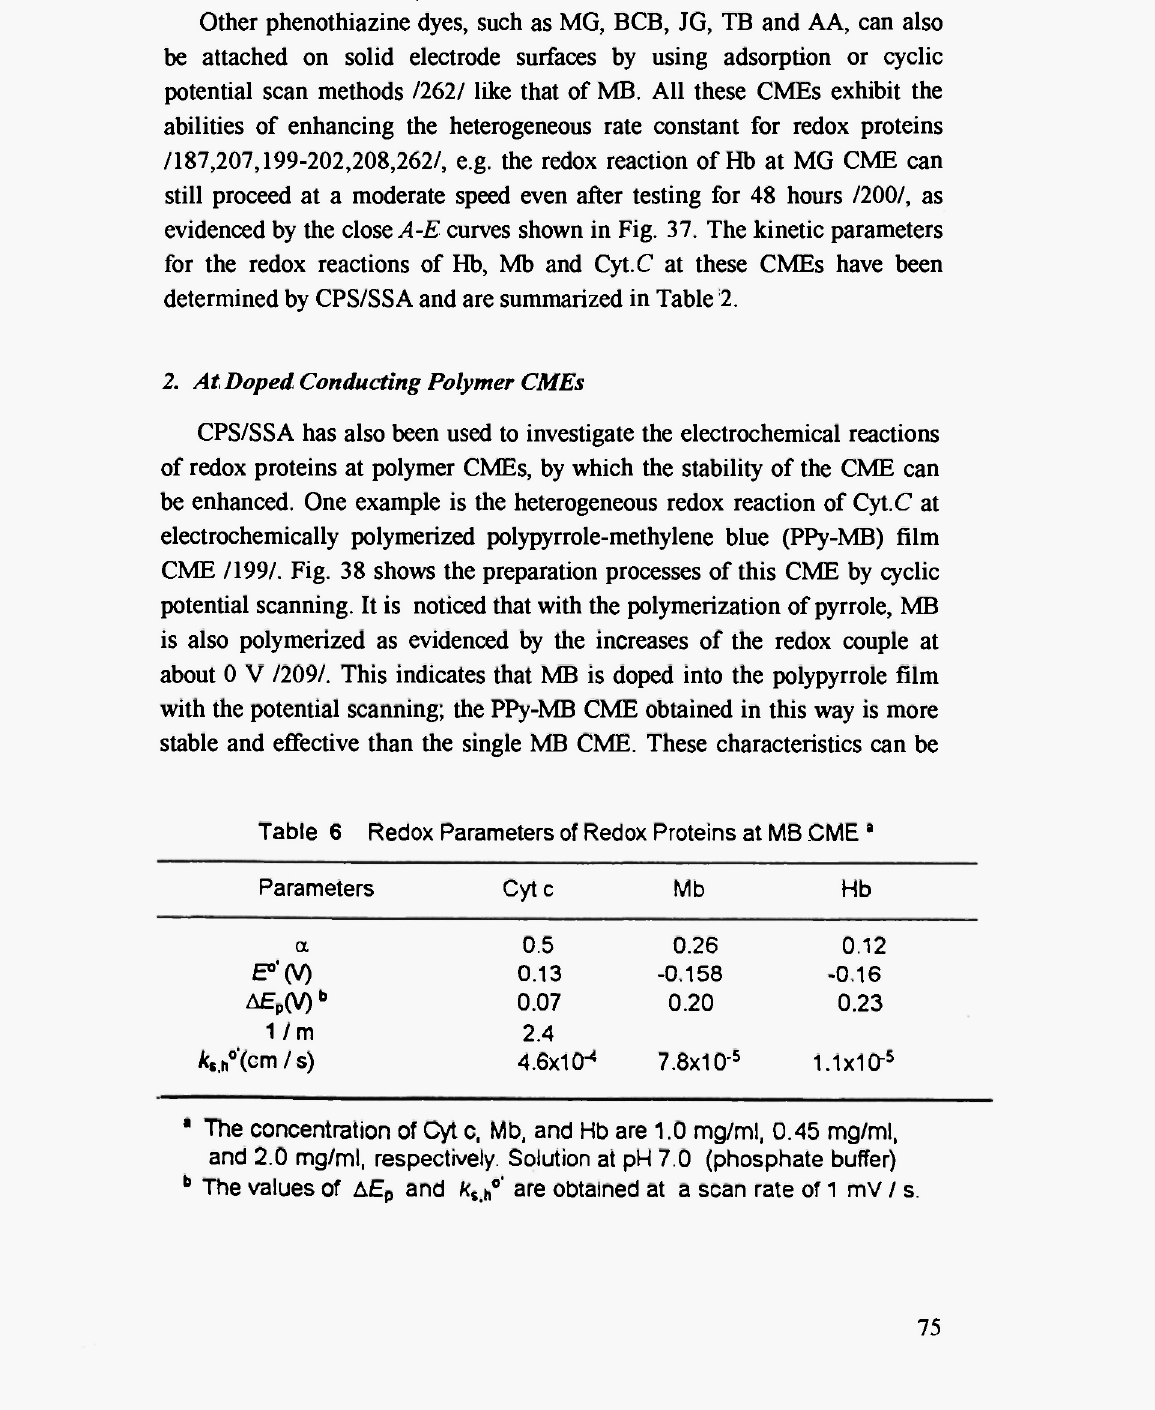
Redox Parameters of Redox Proteins at MB CME